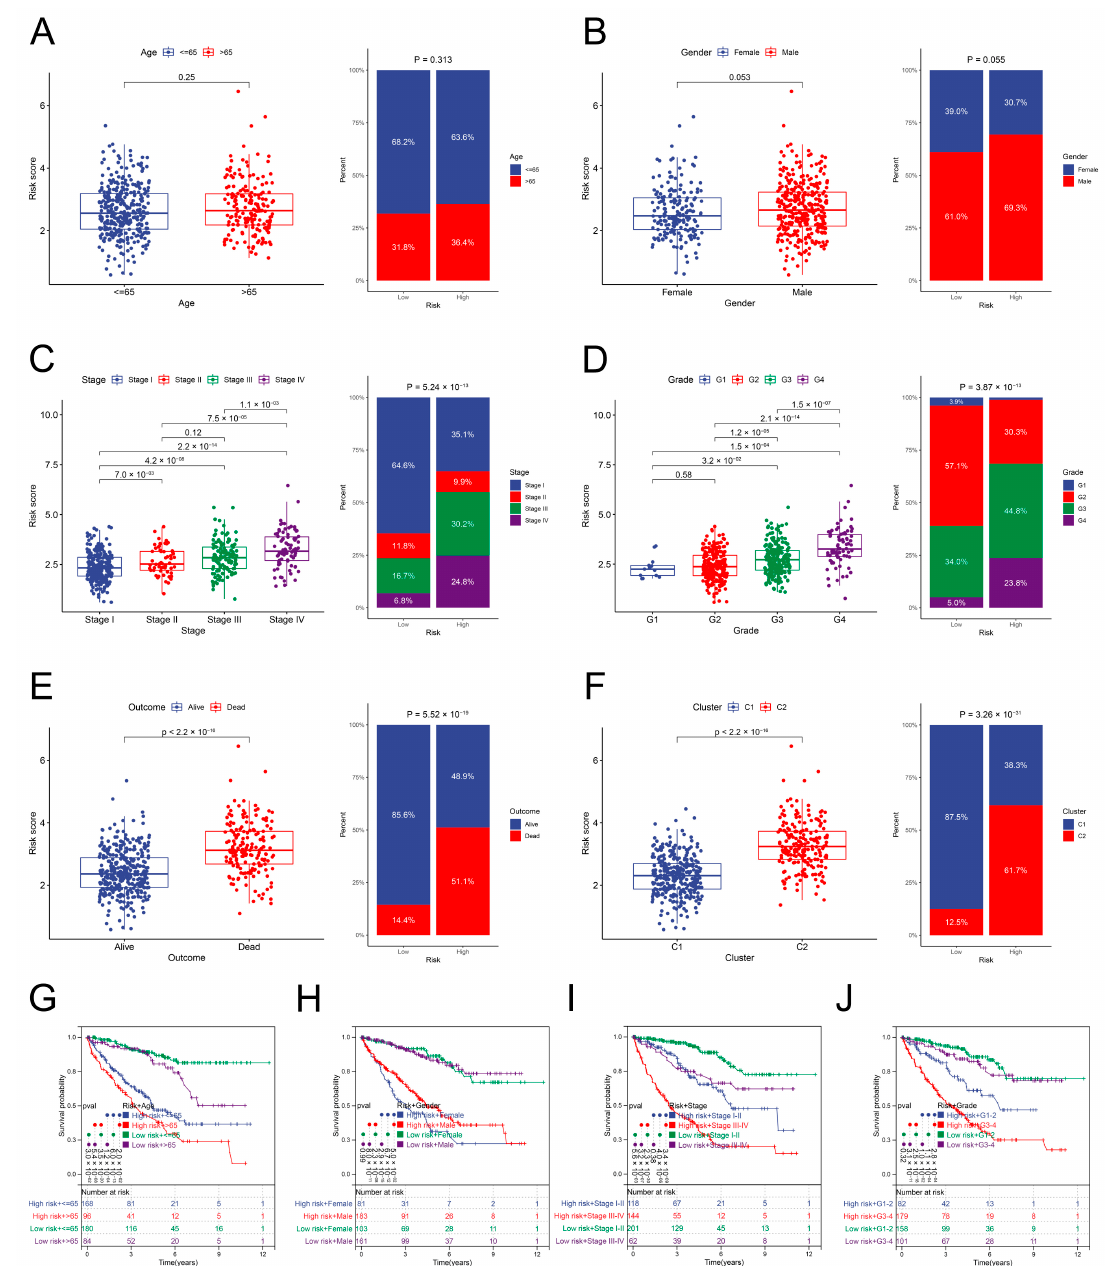
Figure 6. Clinical characteristics of the two risk groups in the TCGA dataset. ( A – F ) Distribution of the risk scores stratified by age, gender, TNM stage, tumor grade, survival status, and inflammation clusters, and the component proportion of clinical characteristics between the two groups. ( G – J ) OS of the ccRCC specimens of different risk groups and diverse clinical characteristics.